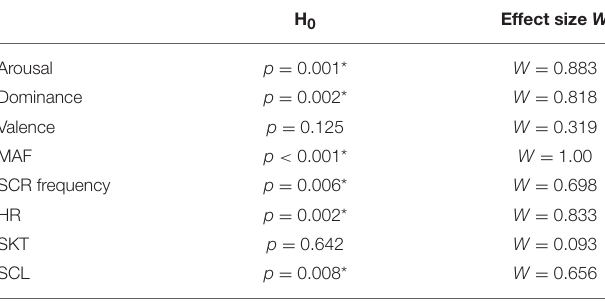
TABLE 2 | Significant differences and effect sizes between game difficulty levels for the eight measured variables. H 0